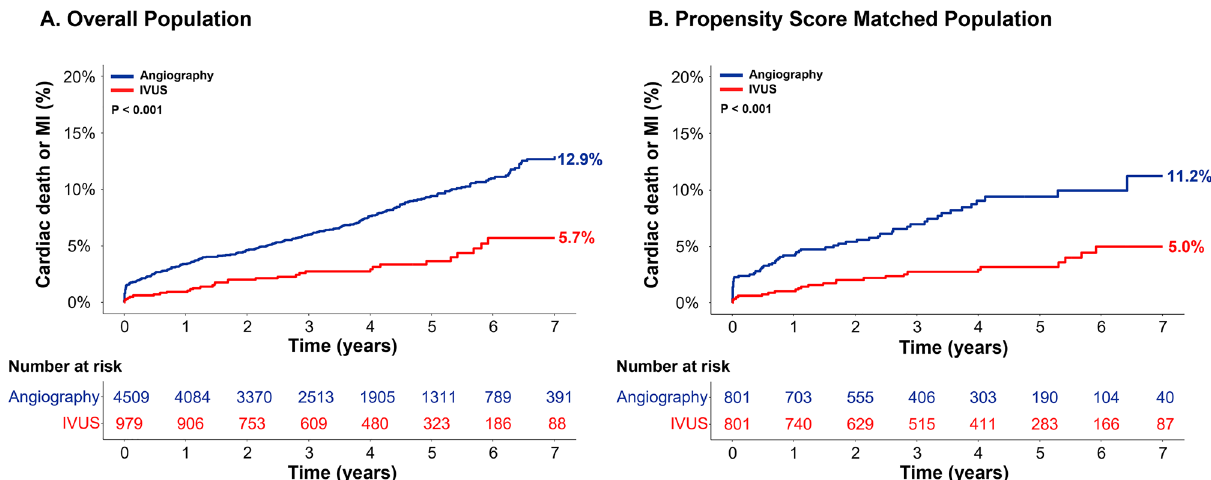
Figure 3. Comparison of primary composite endpoint between IVUS-guided PCI versus angiography-guided PCI in overall and propensity score matched population. The Kaplan–Meier survival curve is shown for the comparison of primary composite endpoint (cardiac death or MI) between IVUS-guided PCI (red line) and angiography-guided PCI (blue line) in overall ( A ) and propensity-matched population ( B ). IVUS, intravascular ultrasound; MI, myocardial infarction; PCI, percutaneous coronary